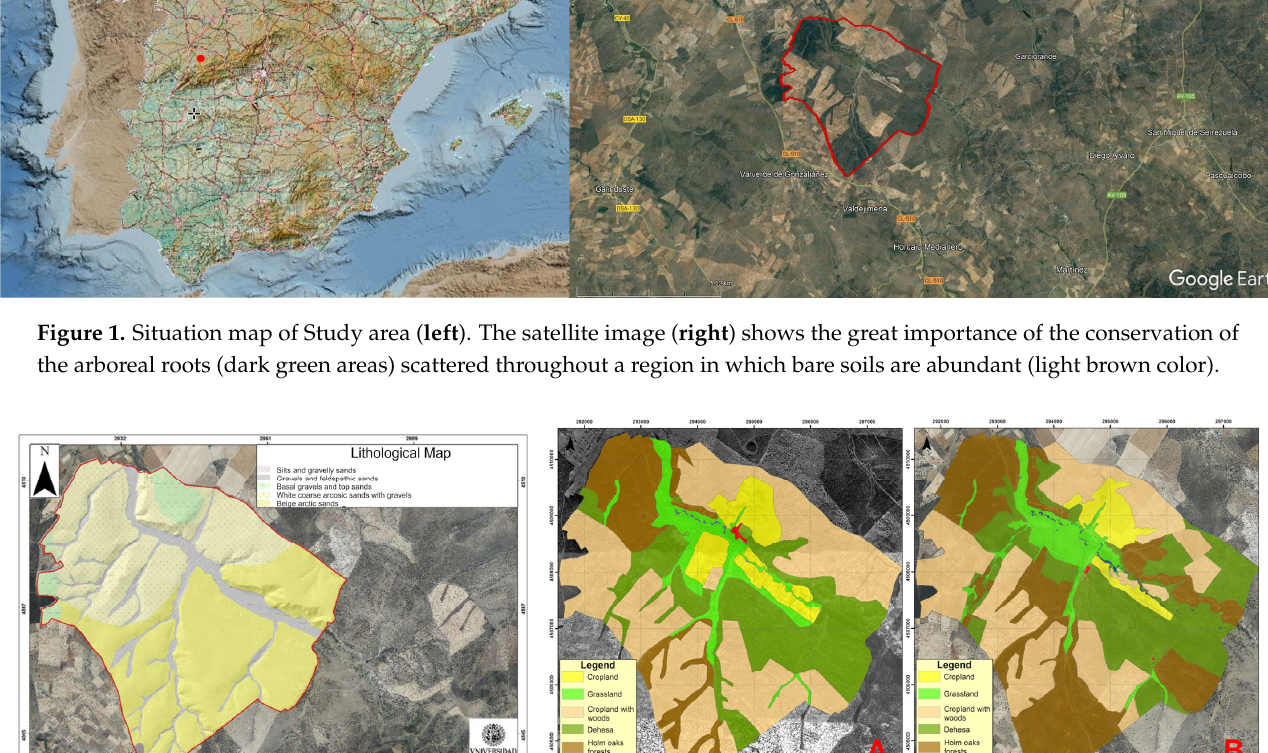
Agronomy 2021 , 11 , x FOR PEER REVIEW 5 of 22